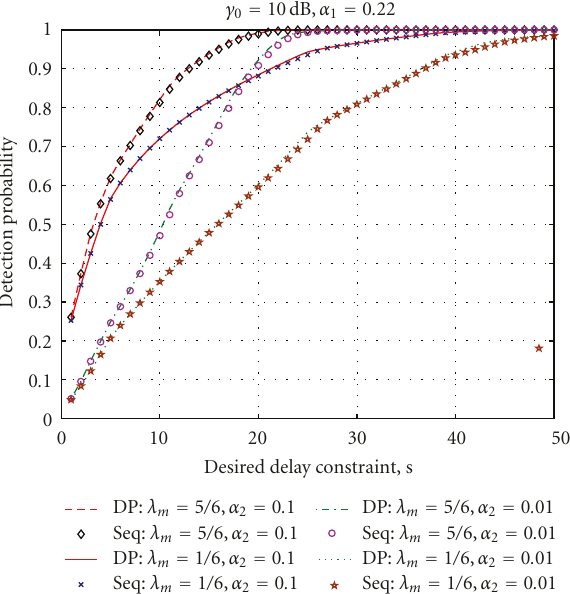
Figure 10: Comparison of the performance of mobility algorithms based on dynamic programming approach and the sequential approach; (cid:2) 1 = 0, (cid:2) 2 = 0; T s = 1s, v = 1m/s, p k = p = 0, α 1 = 0 . 22, γ 0 = 10 dB, target is assumed to be located at (0,0) .